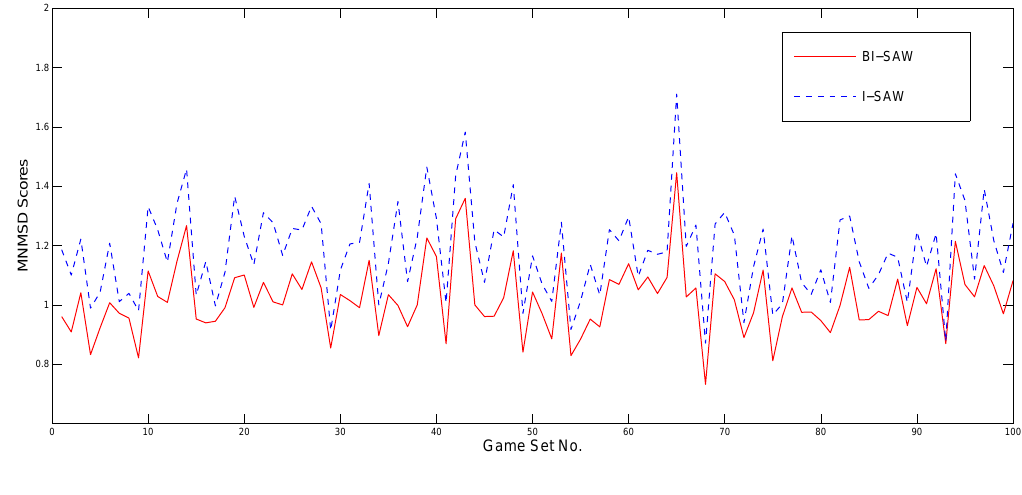
Figure 3. Resampling game set MNMSD scores for the I-SAW and BI-SAW